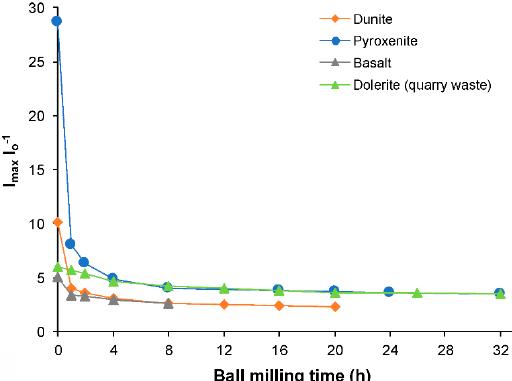
Figure 2. Relationships between the ball milling time (h) and the ratio of maximum intensity ( I max ) to mean background intensity ( I o ) acquired by the powder X-ray diffraction patterns of the unmilled and ball-milled rock samples (after milling with 50 wt% ethanol). The maximum intensity corresponds to the peak with the highest intensity in each XRD pattern, and the mean background intensity is the average of four background intensities (data from Rigopoulos et al. [19,25,32,33]).